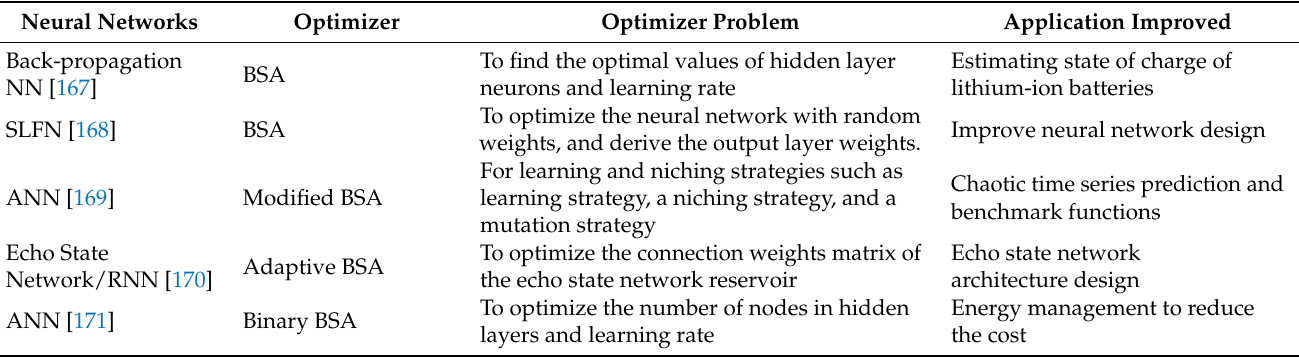
Table 7. Studies involving BSA for neural network design and application